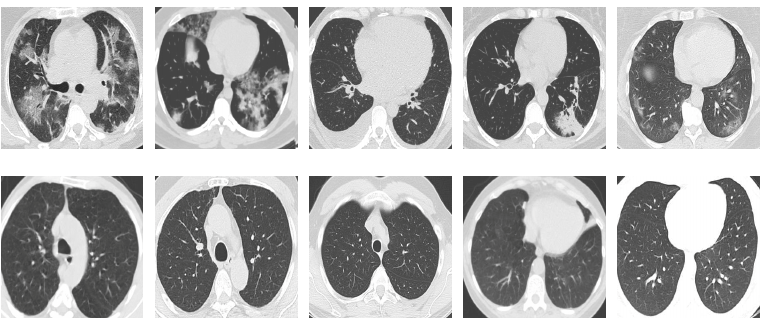
Figure 7. Examples of chest CT scans from the SARS-CoV-2 CT dataset. The first row represents CT scans diagnosed with COVID-19, whereas the second row represents non-COVID-19.